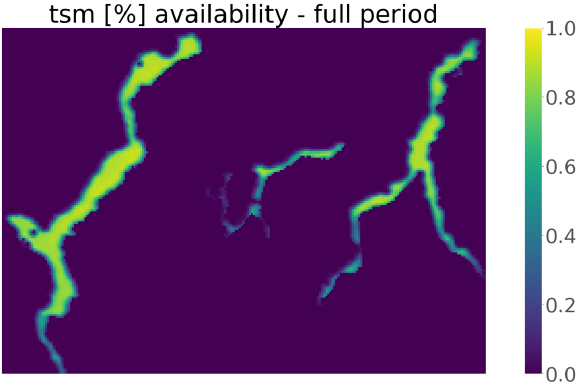
Figure 2. Data availability - TSM, full